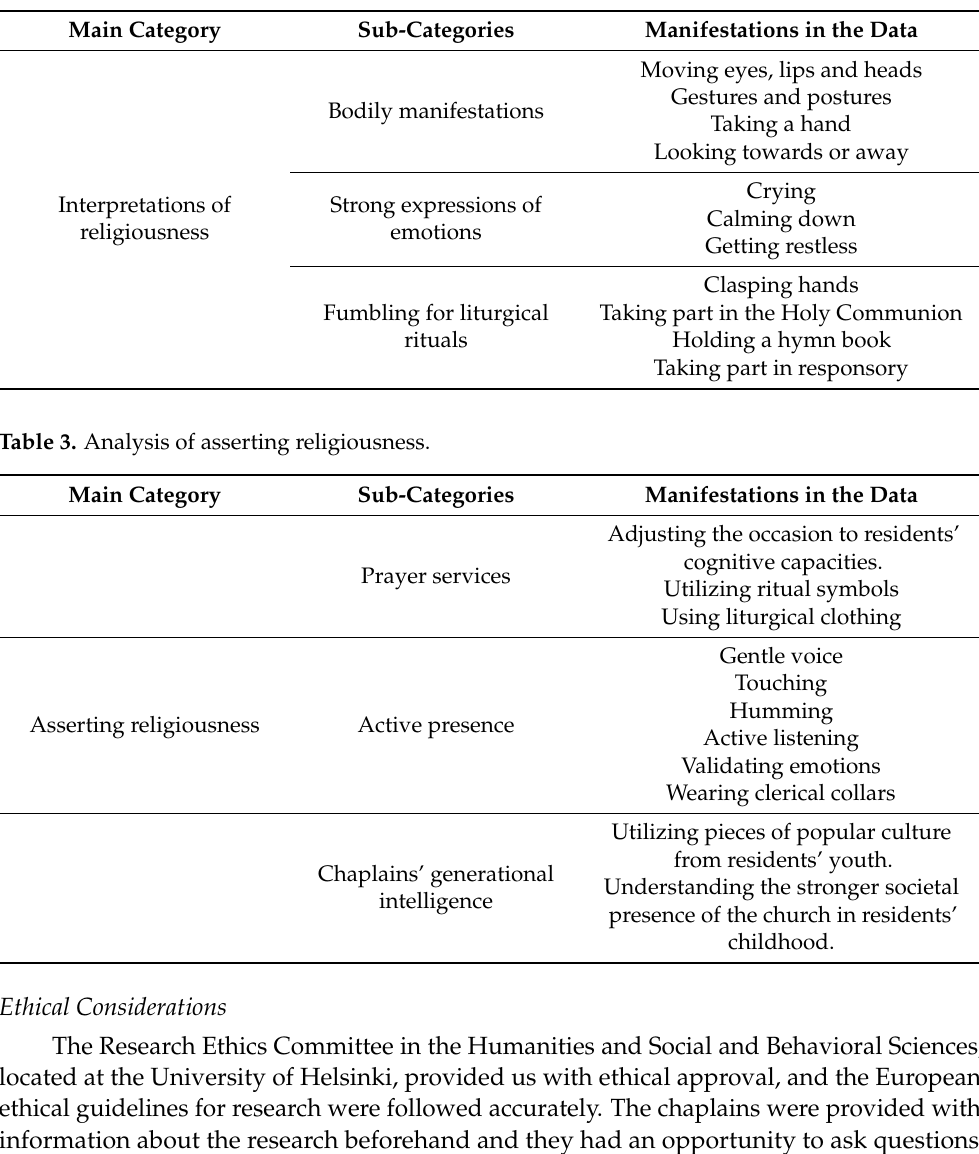
Table 2. Analysis of chaplains’ interpretations of religiousness.